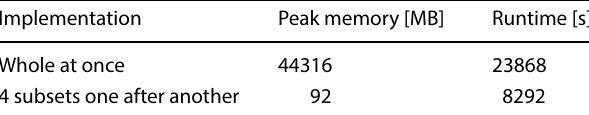
Table 6 The effect of dividing the problem into